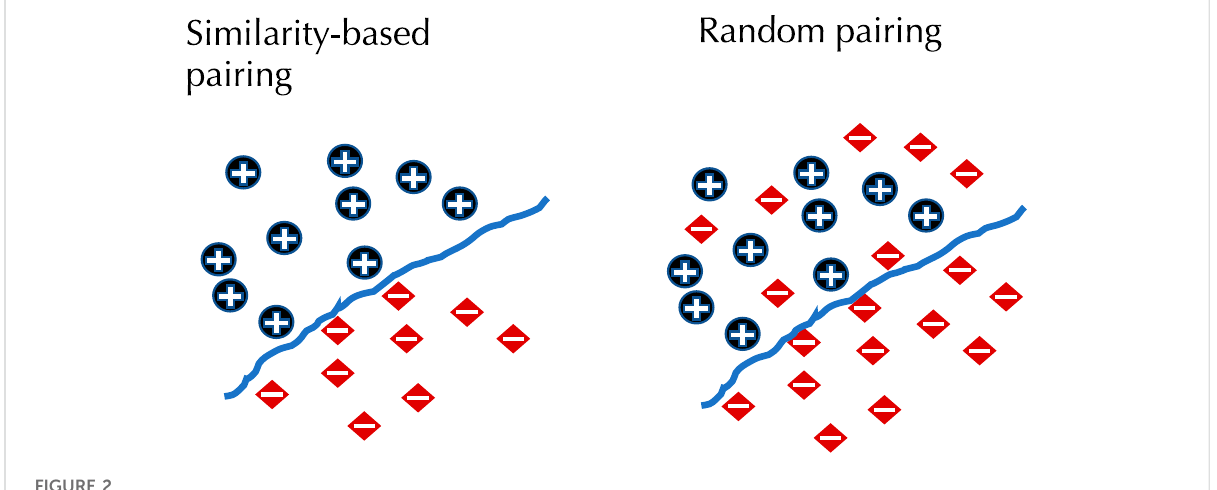
FIGURE 2 The effect of similarity-based selection of negative examples. When using similarity-based selection of negative examples this forces a distinction between positive and negative examples, making the problem much easier to